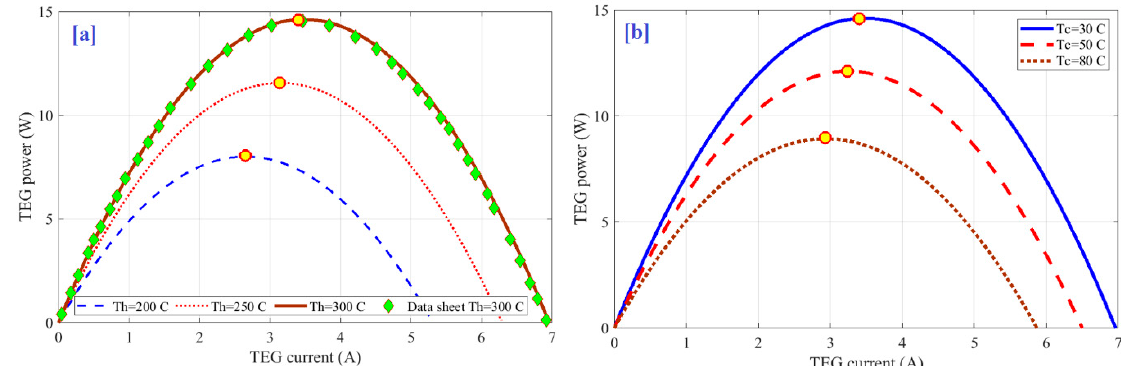
Figure 4. Power versus current of the TEG: ( a ) changing the hot side temperature by maintaining the cold side at a tem- perature of 30 °C; ( b ) changing the cold side temperature by maintaining the hot side at a temperature of 300 °C.